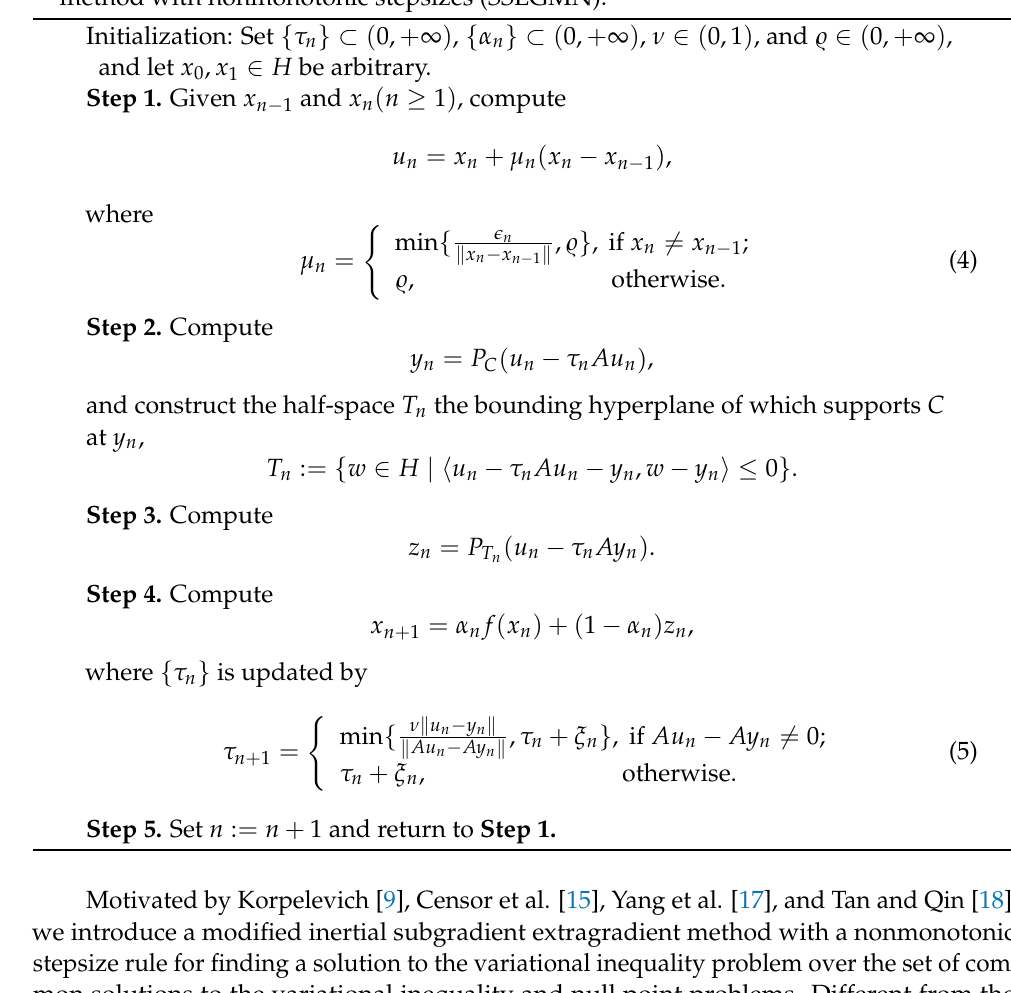
Algorithm 3: Self adaptive viscosity-type inertial subgradient extragradient method with nonmonotonic stepsizes